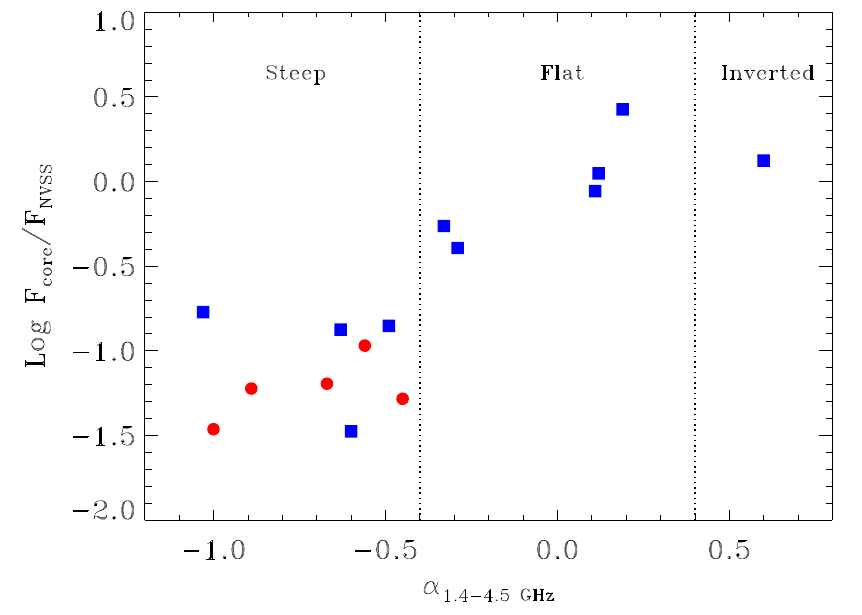
Figure 4. The 1.4–4.5 GHz spectral slope ( S ν ∝ ν α ) measured from the JVLA data [64,72] as a function of the core dominance, estimated as the ratio of the flux density of the pc-scale core component measured from our e MERLIN and EVN data and the total extended emission from NVSS flux density. Red circles mark the e MERLIN FR 0s and blue squares the EVN FR 0s. The vertical dashed lines denote the steep-spectrum sources ( α < − 0.4), the flat-spectrum sources ( − 0.4 < α < 0.4), and the inverted-spectrum sources ( α >